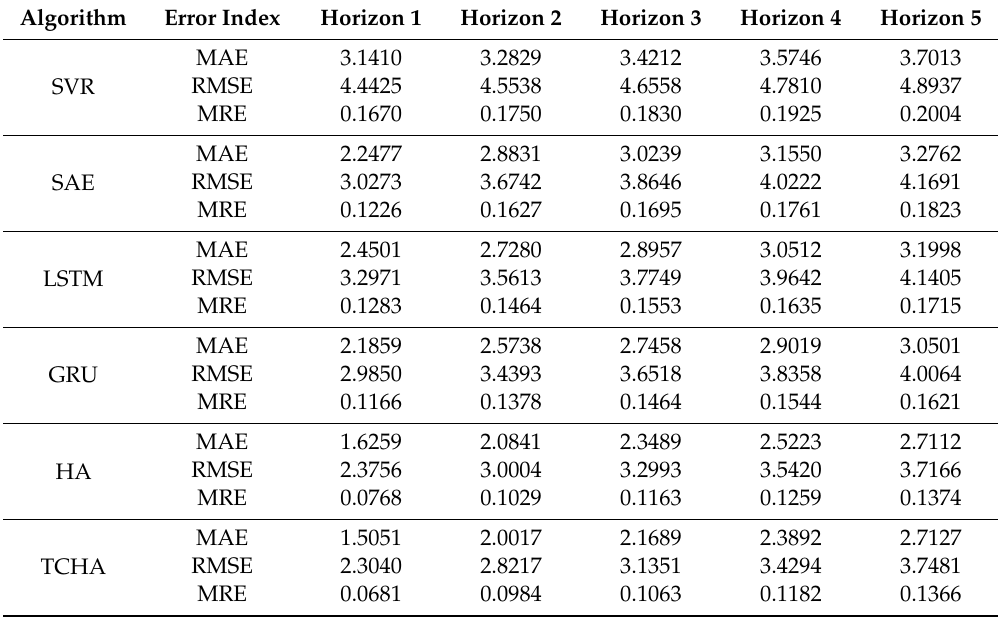
Table 1. Performance of di ff erence prediction horizons (Shixin Road).